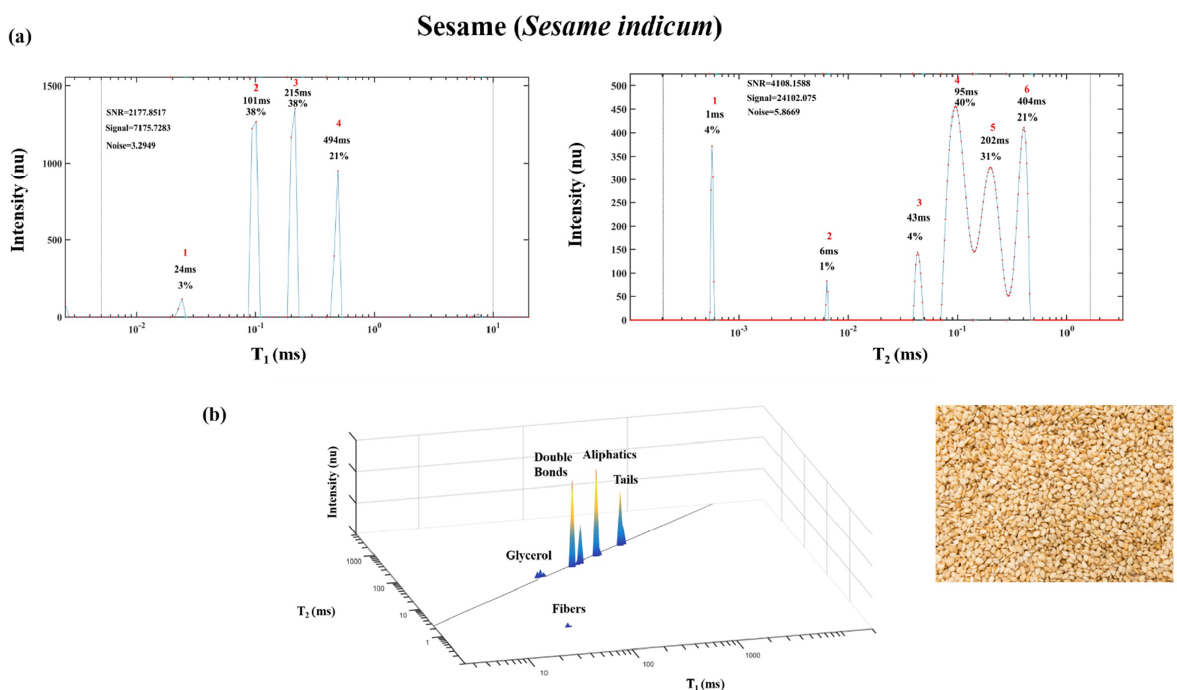
Figure 9. One-dimensional T 1 and T 2 spectra of sesame seeds ( Sesamum indicum ) ( a ) and 2D T 1 -T 2 spectra ( b ). Image of sesame seeds (bottom